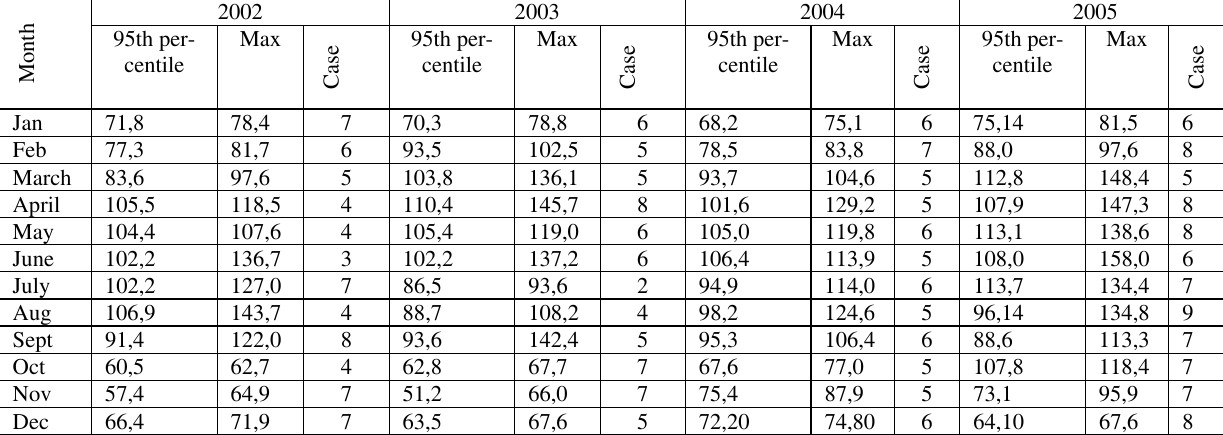
Table 2. The 95th percentile and maximum of ozone concentration in μ g/m 3 and the number of selected cases at Preila station in